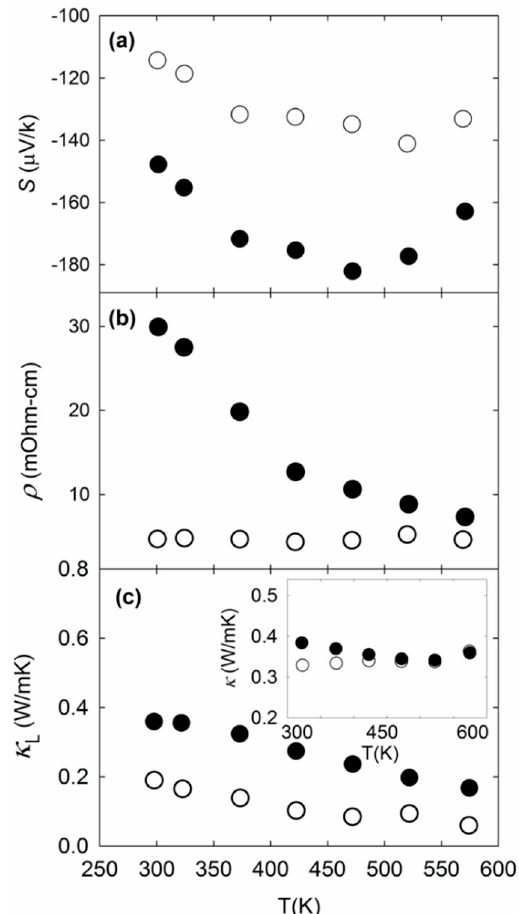
Figure 4. ( a ) S ; ( b ) ρ ; and ( c ) κ L of K 2.9(4) Ba 13.1(2) Ga 23.2(3) Sn 112.7(5) (empty circles) and K 7.1(2) Ba 8.8(3) Ga 25.1(4) Sn 110.8(3) (filled circles). The κ L values were estimated using the Wiedemann–Franz relation κ L = κ − κ e , where κ e (= L 0 T / ρ ) is the electronic contribution and the Lorenz number, L 0 , is taken to be 2.0 × 10 − 8 V 2 /K 2 . The inset to ( c ) shows the measured κ values of both specimens, with symbols as denoted previously.